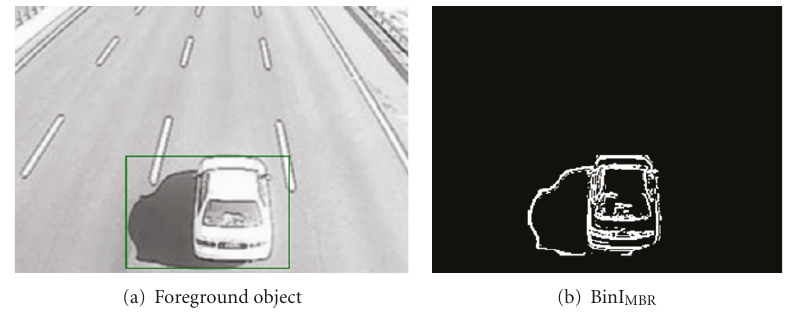
Figure 10: Homogeneous property of shadows, example 1.